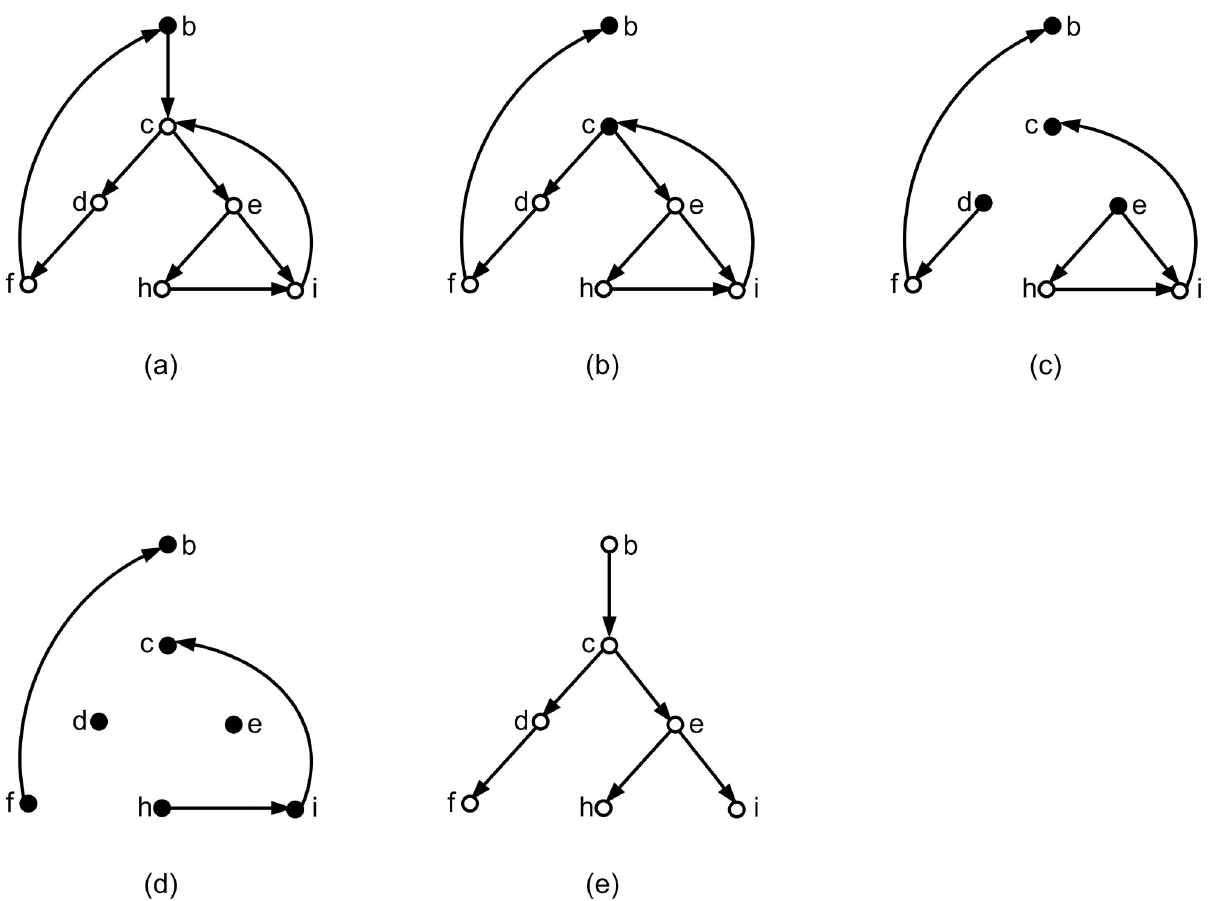
Fig 14. The process of assigning black and white color to the nodes of a graph with no node with in-degree zero or out-degree zero. (a) The first step of nodes coloring, by considering the node b as the starting point. (b-d) The next three steps of the nodes coloring. (e) A DAG is obtained from Fig 14a by removing the edges that are determined in the graph of Fig